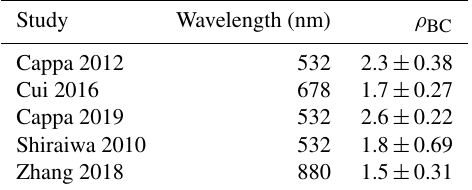
Figure 6. (a–b) MAC BC calculated using Mie theory (calculated MAC BC ) as a function of MAC BC and error incurred by using Mie theory as a function of core fractal dimension ( D f ). (c–d) MAC BC calculated using Eq. (3) (calculated MAC BC ) as a function of MAC BC and error incurred by using Eq. (3) as a function of D f . In panels (b) and (d) , the shaded region shows the range of errors (1 standard deviation). The scaling laws given in this work are more consistent than Mie theory in calculating MAC BC for aggregates with arbitrary morphology. Table 2. Previous studies which find little to no increase in MAC BC with increasing R BC and the corresponding average ρ BC which replicates the measured MAC BC . Using Eq. (3b), we are able to es- timate ρ BC of aggregates from studies which find values of MAC BC that are significantly lower than that predicted by Eq. (3a) (Cappa et al., 2012; Shiraiwa et al., 2010; Cappa et al., 2019; Zhang et al., 2018; Cui et al., 2016). The error in ρ BC is 1 standard deviation.